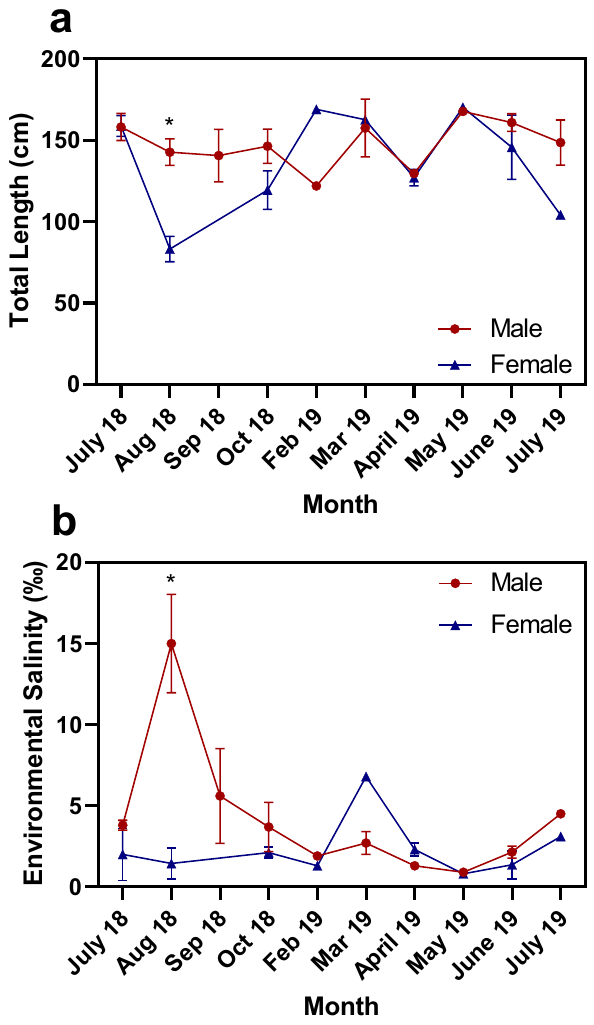
Figure 2. Monthly variation in total length ( a ) of wild juvenile American alligators ( Alligator mississippiensis ) and environmental salinity in which animals were located ( b ). *Denotes significant differences between males and females during the indicated